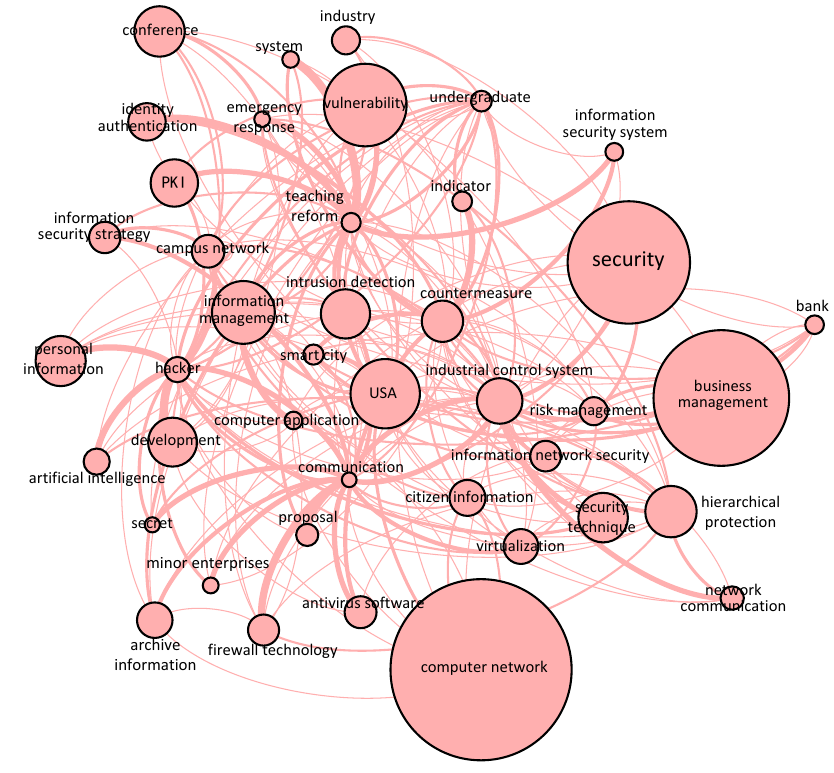
Figure 6. Complex networks of 42